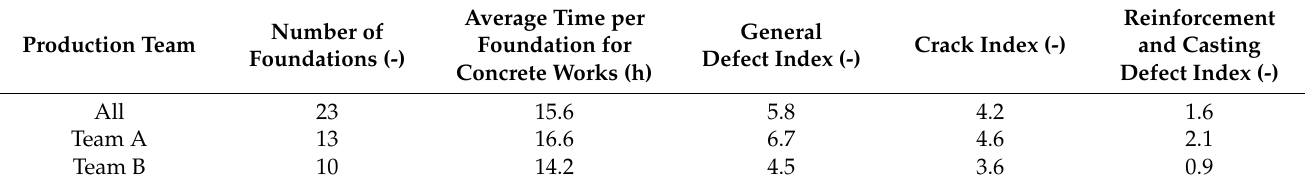
Table 3. Production time per foundation and defect index for each production team.